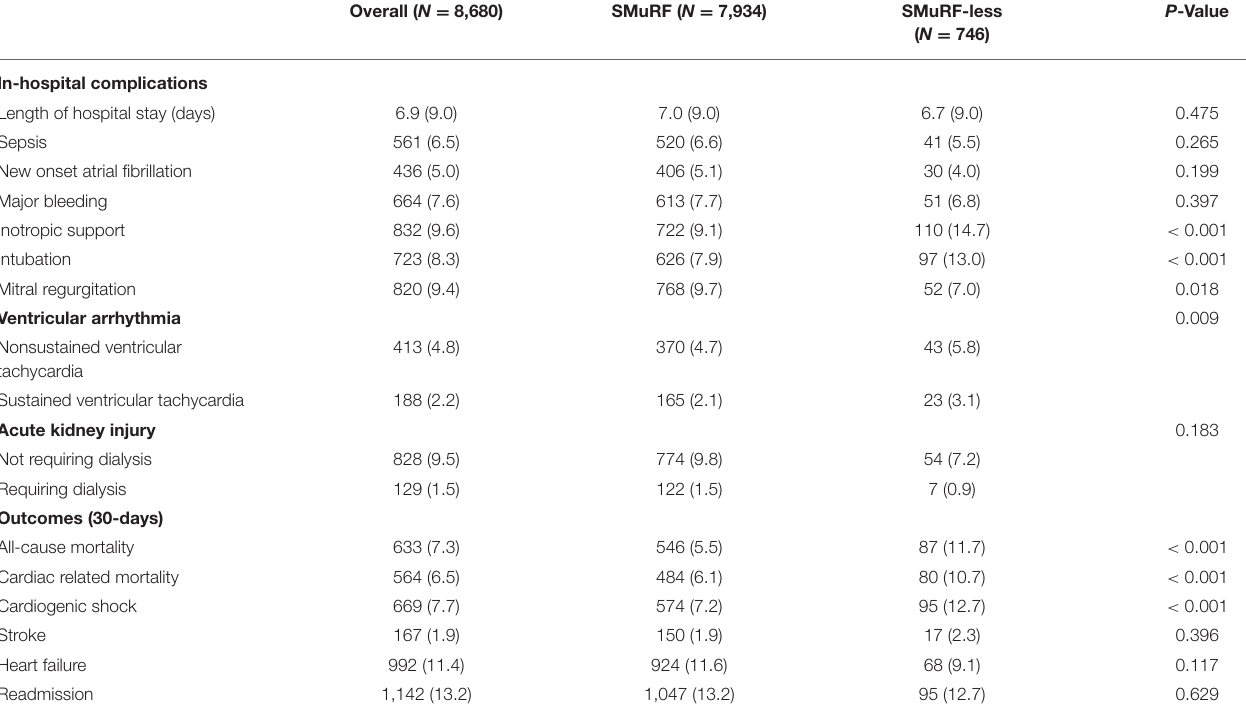
TABLE 2 | In-Hospital complications and outcomes of study cohort presenting with acute myocardial infarction, based on standard modifiable cardiovascular risk factors. Overall ( N = 8,680) SMuRF ( N = 7,934) SMuRF-less